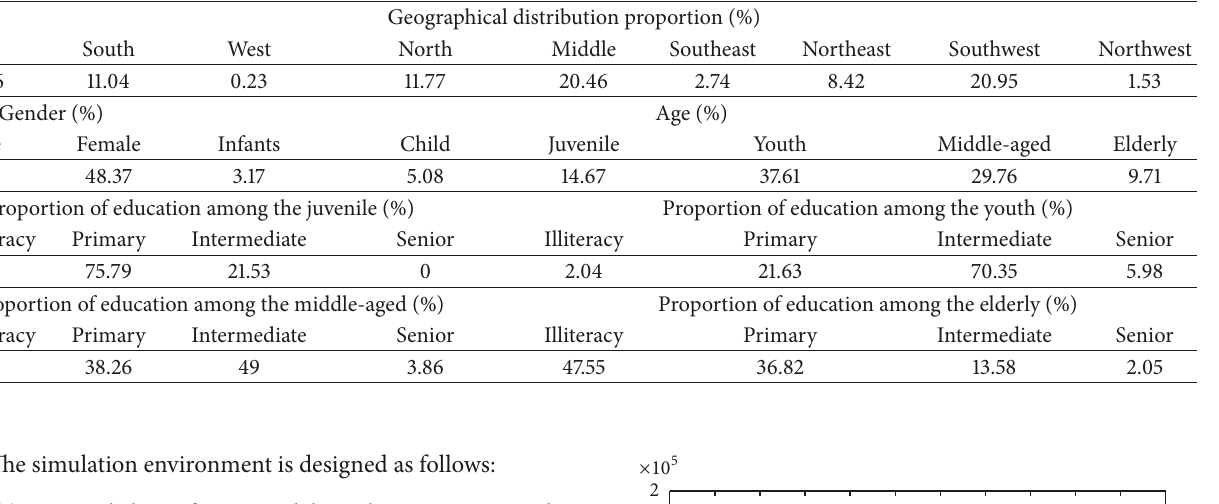
Table 1: The statistical data of the fifth population consensus.